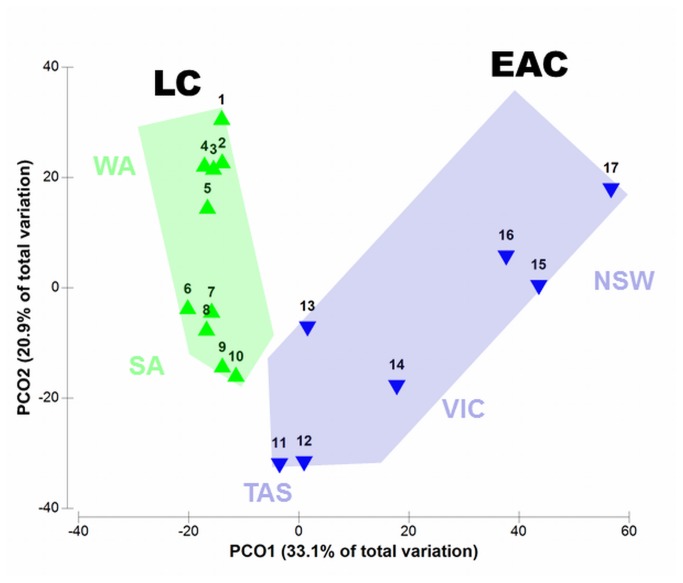
Principal Component Ordination (PCO) of seaweed community structure from bioregions swept by the Leeuwin Current (LC = green triangles) and the East Australia Current (EAC = blue triangles).See Figure 1 for spatial arrangement of regions. The green and blue arrows indicate the current systems super-imposed onto the ordination to illustrate the magnitude of floristic change across the current system (length of arrow) and the variation in community structure among regions within the system (width of arrow). There was significant sequential change in community structure along both current systems.